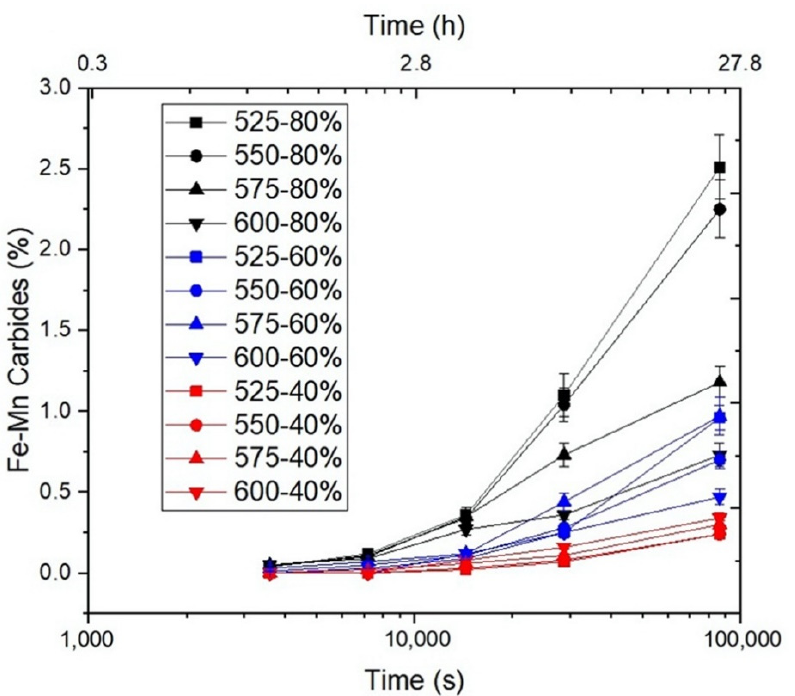
Figure 7. Volume percent of Fe-Mn-Carbide precipitation on 40, 60, and 80% cold-deformed samples annealed at different temperatures.